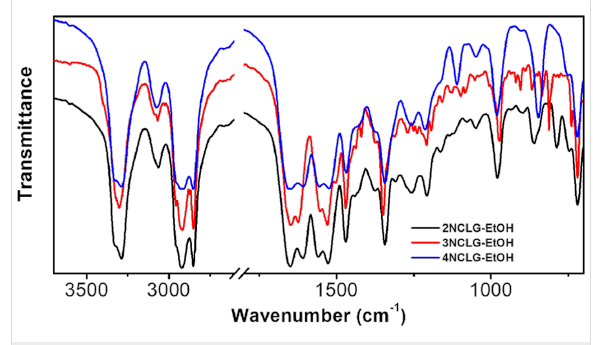
Figure 5: FTIR spectra of the 2NCLG assembly (black), 3NCLG assembly (red) and 4NCLG assembly (blue) obtained in EtOH.